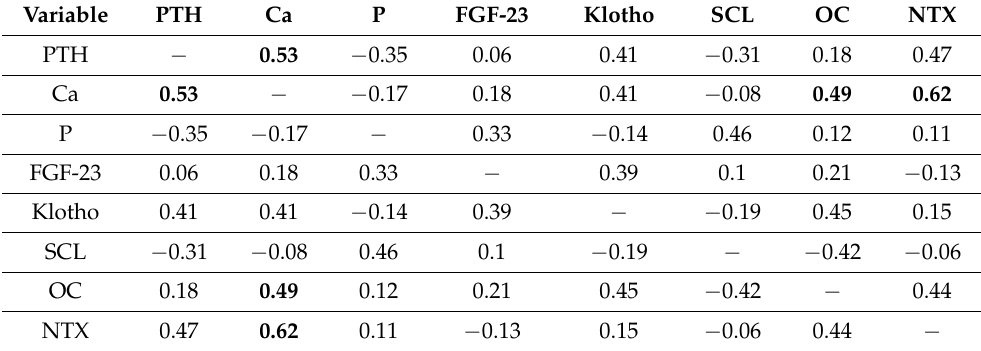
Table 7. Spearman’s rank correlation coefficients (significant in